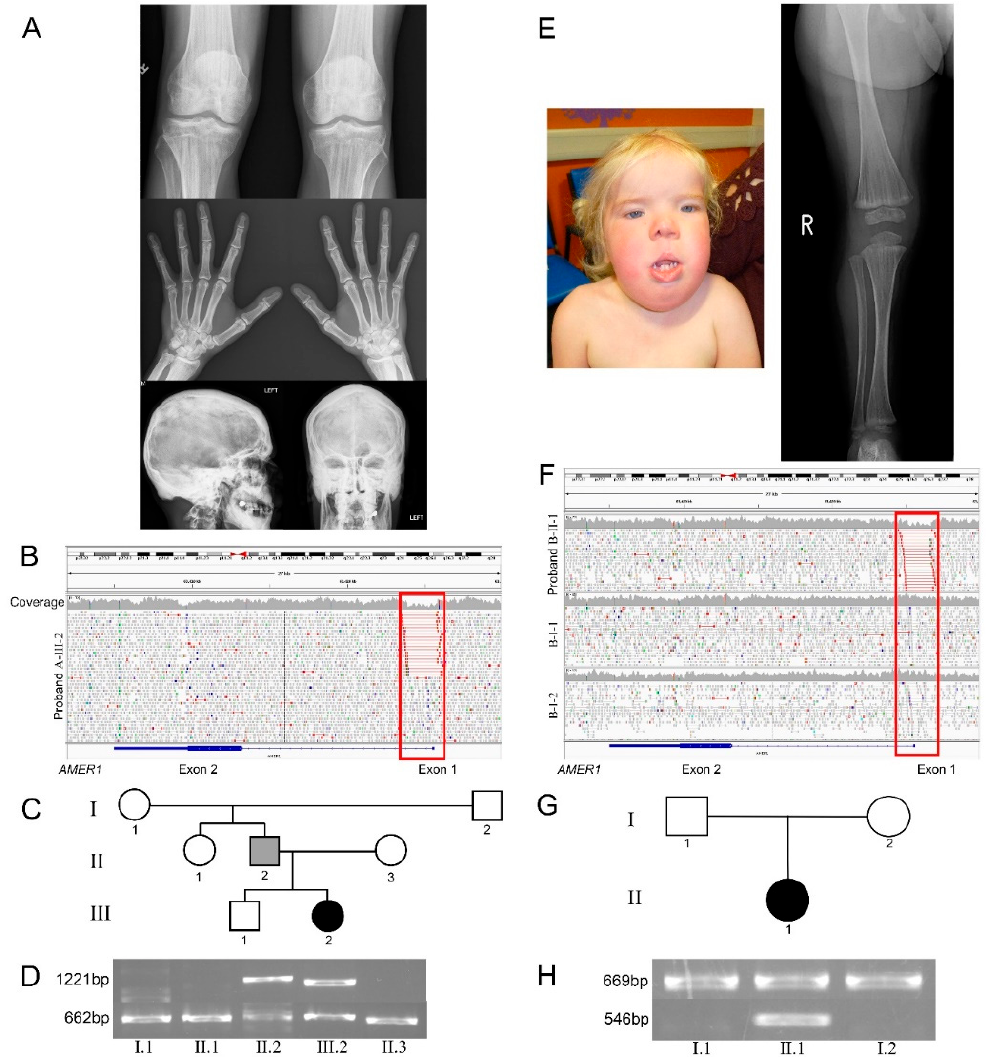
Figure 1. Clinical and sequence data from families A and B. ( A ) Radiographs from the proband of family A showing metaphyseal striations, cranial sclerosis, and osteosclerosis in the proband; ( B ) Integrated genome viewer (IGV) screen-shot illustrating the deletion NC_000023.10:63423844_63425768, encompassing exon 1, in the proband (red box). ( C ) Pedigree and ( D ) PCR results from family A showing individuals I-1, II-2 and II-3 have a band of 662 bp corresponding to DNA amplified by primer pair 2, the proband III-2 and her father II.2 have bands of both 662 bp and 1221bp corresponding to DNA amplified by both sets of primers. ( E ) Clinical image and radiographs from the proband of family B showing macrocephaly, hypertelorism and metaphyseal striations. ( F ) An IGV screen-shot showing a de novo deletion NC_000023.10:63425070_63426641 in the proband (red box). ( G )